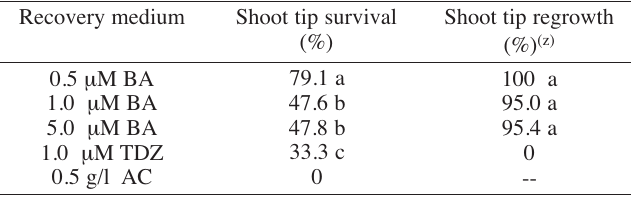
(z) In each column, percentages followed by different letters are signi- ficantly different at P ≤ 0.05 by the post hoc Multiple Comparison